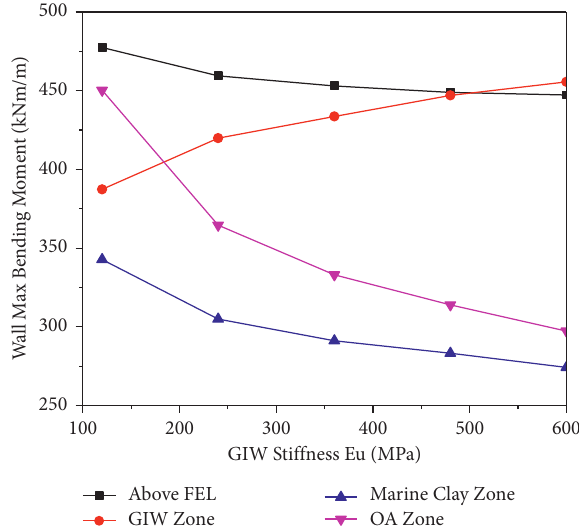
Figure 15: The effect of ground improvement Eu on maximum wall bending moment.